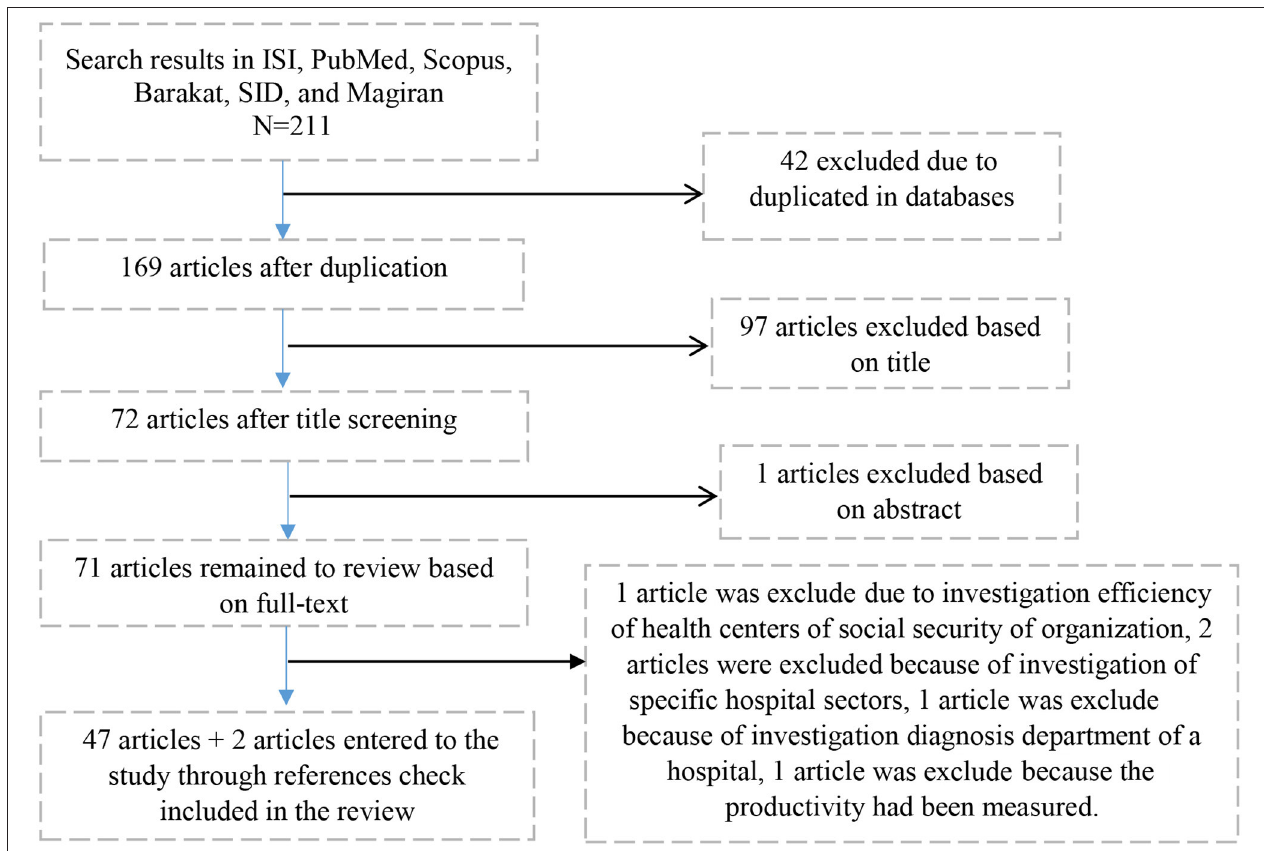
FIGURE 1 | Flow chart of systematic search and studies